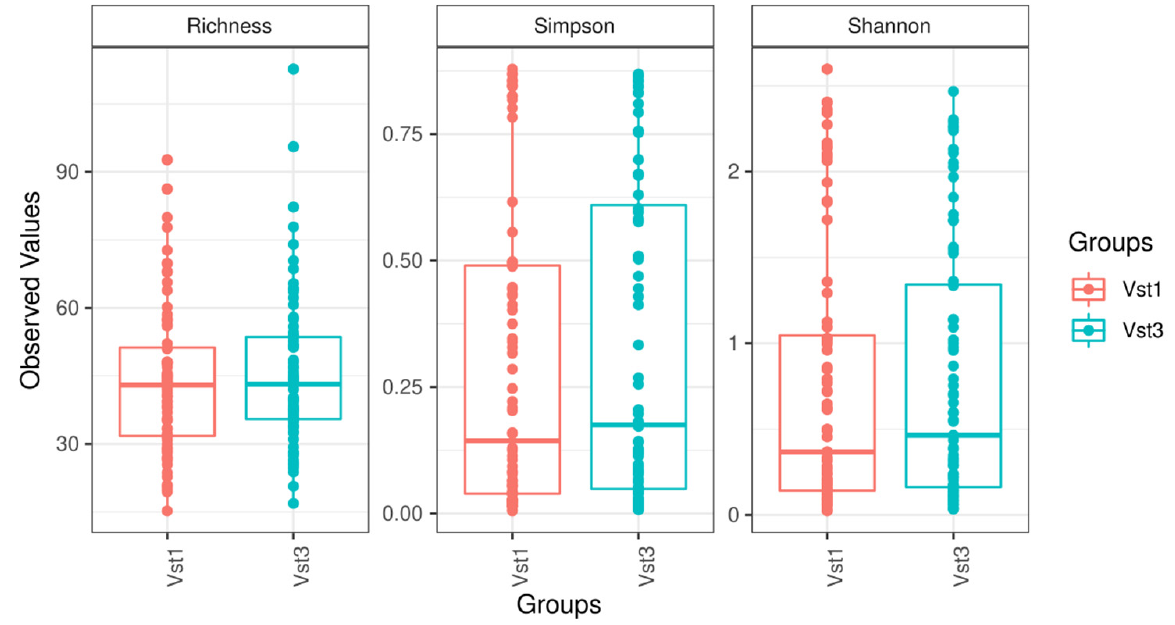
Figure 2. Boxplot figures representing sample diversity based on the variables studied at each visit. Vst1: baseline visit, red. Vst3: final visit, blue.